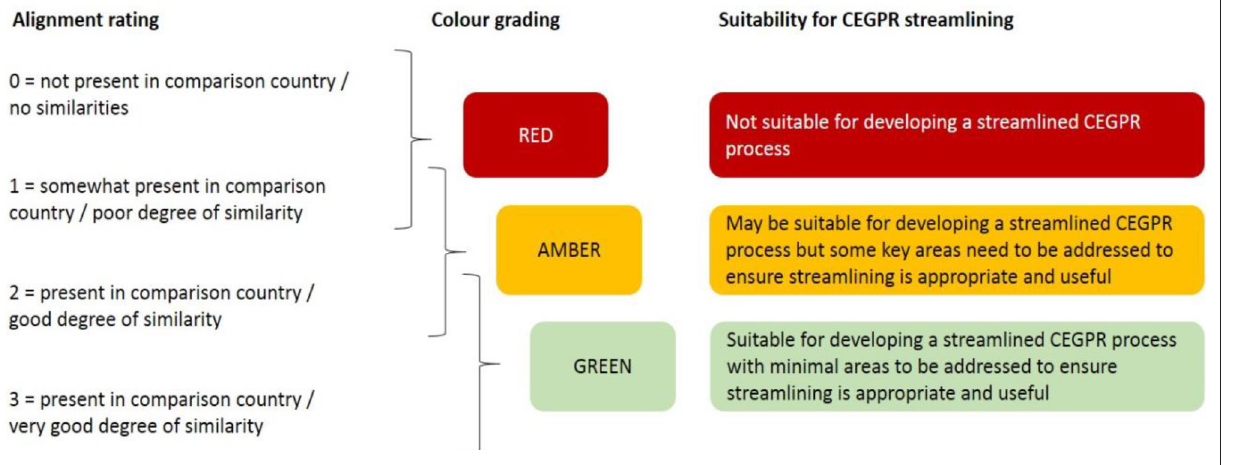
Figure 1 Alignment- rating system (colour). CEGPR = Certificate of Eligibility for General Practice